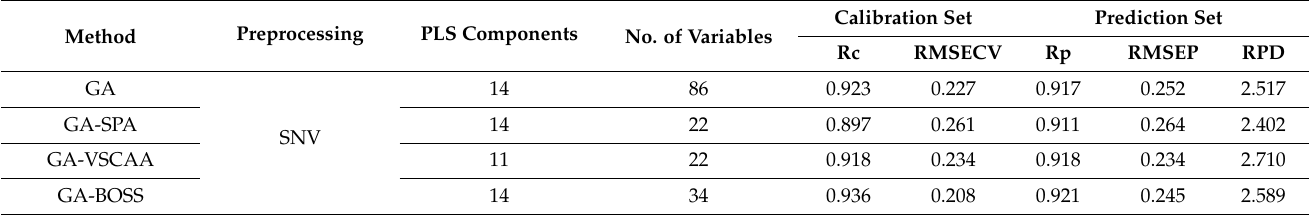
Table 4. PLSR modeling results for SSC based on variables selected by the GA, GA-SPA, GA-VSCAA and GA-BOSS algorithms. Method